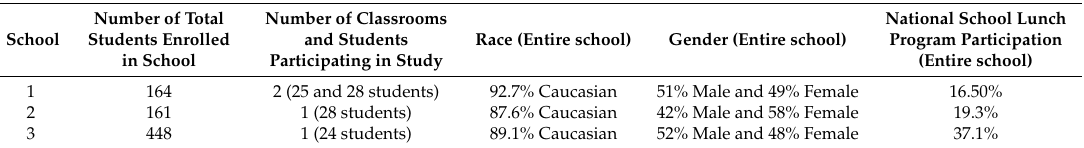
Table 2. Demographics from the three schools involved in the research study [33,34].